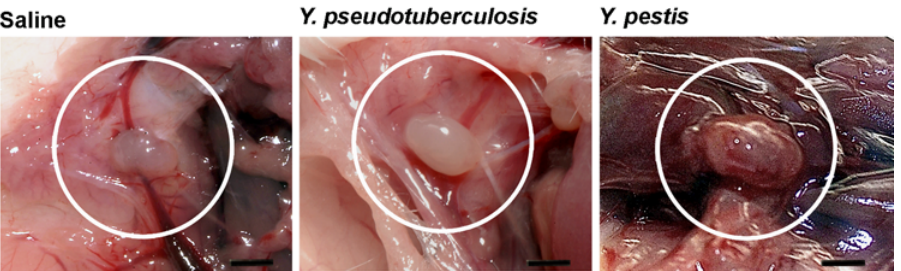
Figure 3. Draining lymph node gross pathology. Macroscopical aspect of lymph nodes two days after inoculation of either saline, , 5500 Y. pseudotuberculosis cfu or , 5500 Y. pestis cfu. Lymph node from Y. pseudotuberculosis -infected mice is purulent whereas Y. pestis -infected lymph node is reddish and adherent to neighboring tissues. Bar=2 mm.